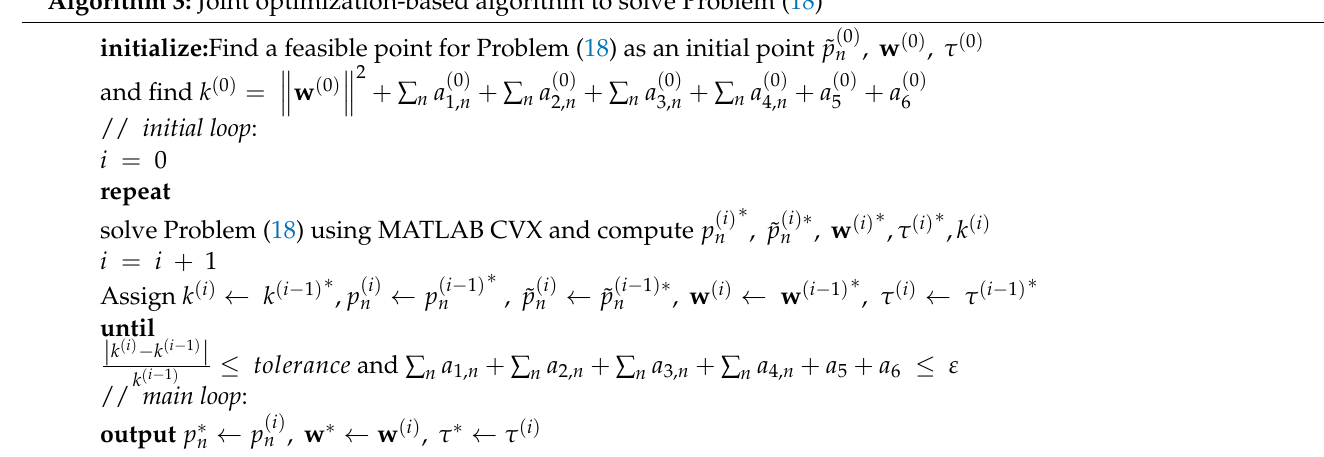
Algorithm 3: Joint optimization-based algorithm to solve Problem